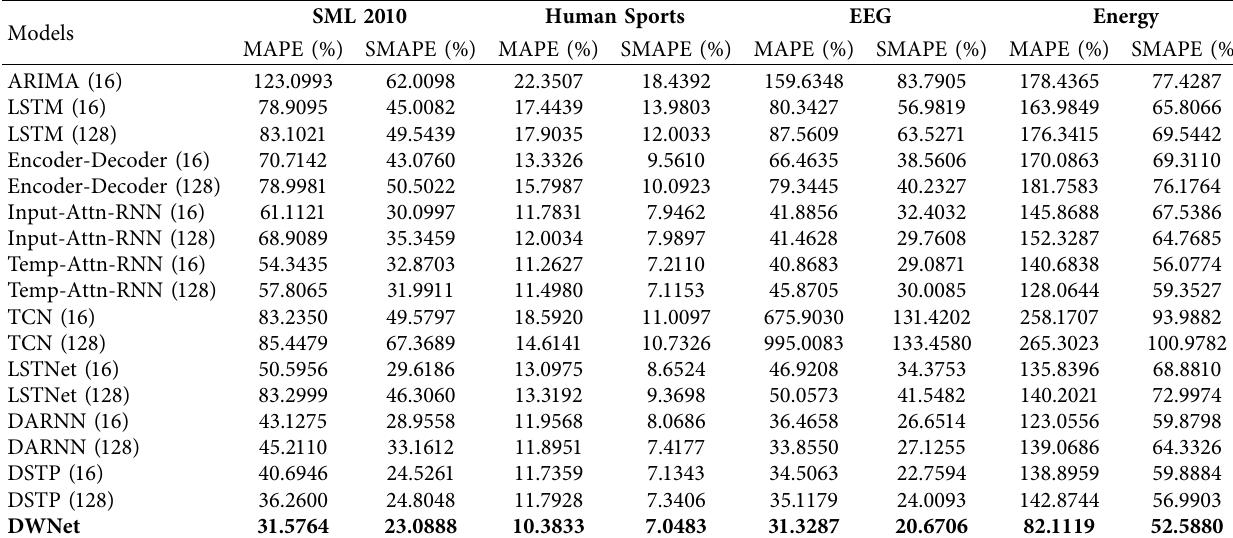
Table 2: MAPE and SMAPE performance comparison among different methods and datasets (best result is displayed in boldface ).